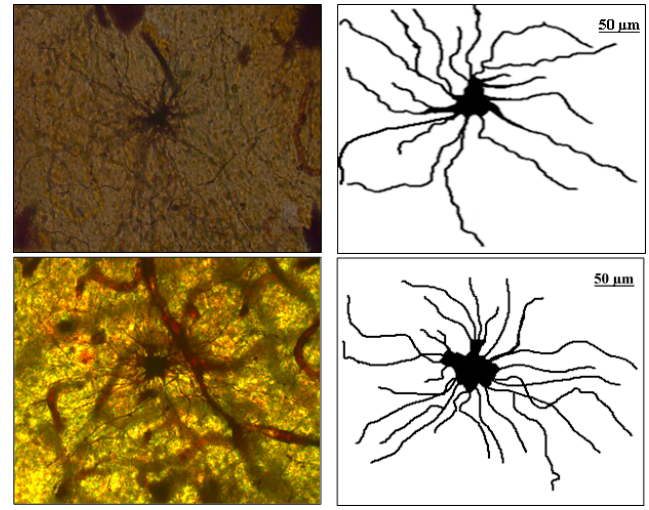
Figure 1. First image line: Optical slice cross-section of fibrous astrocyte in PON and attributed (right) binary image. Second image line: Optical slice cross-section of protoplasmic astrocyte in PON and attributed (right) binary image.